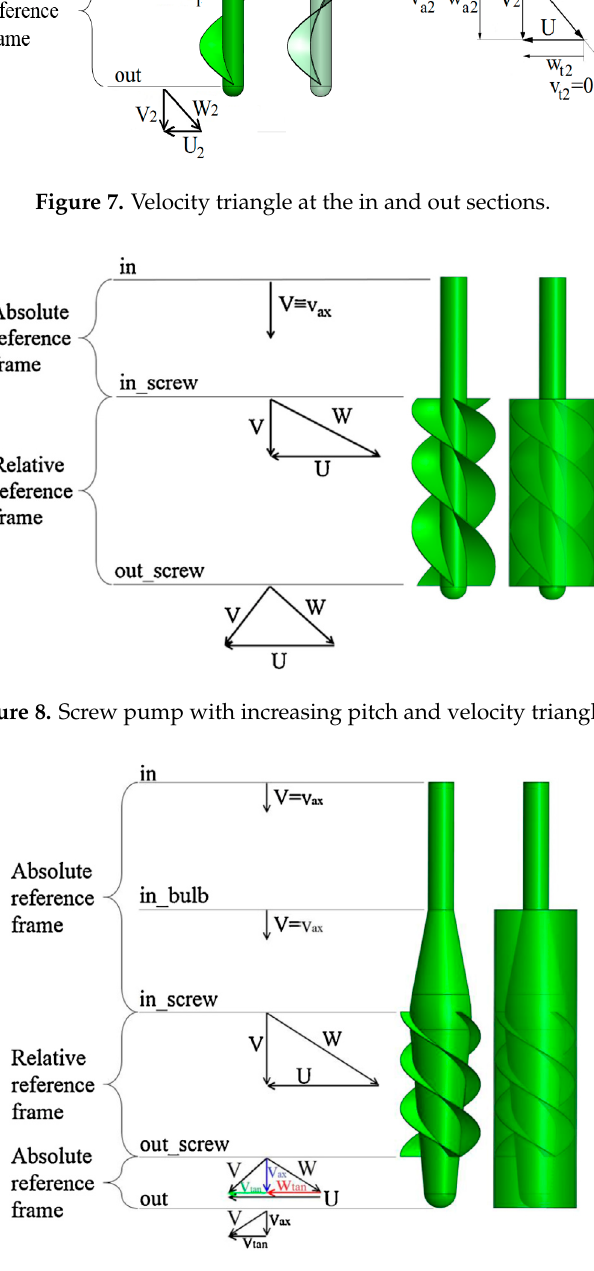
Figure 9. Screw pump with variable hub diameter and velocity triangles.